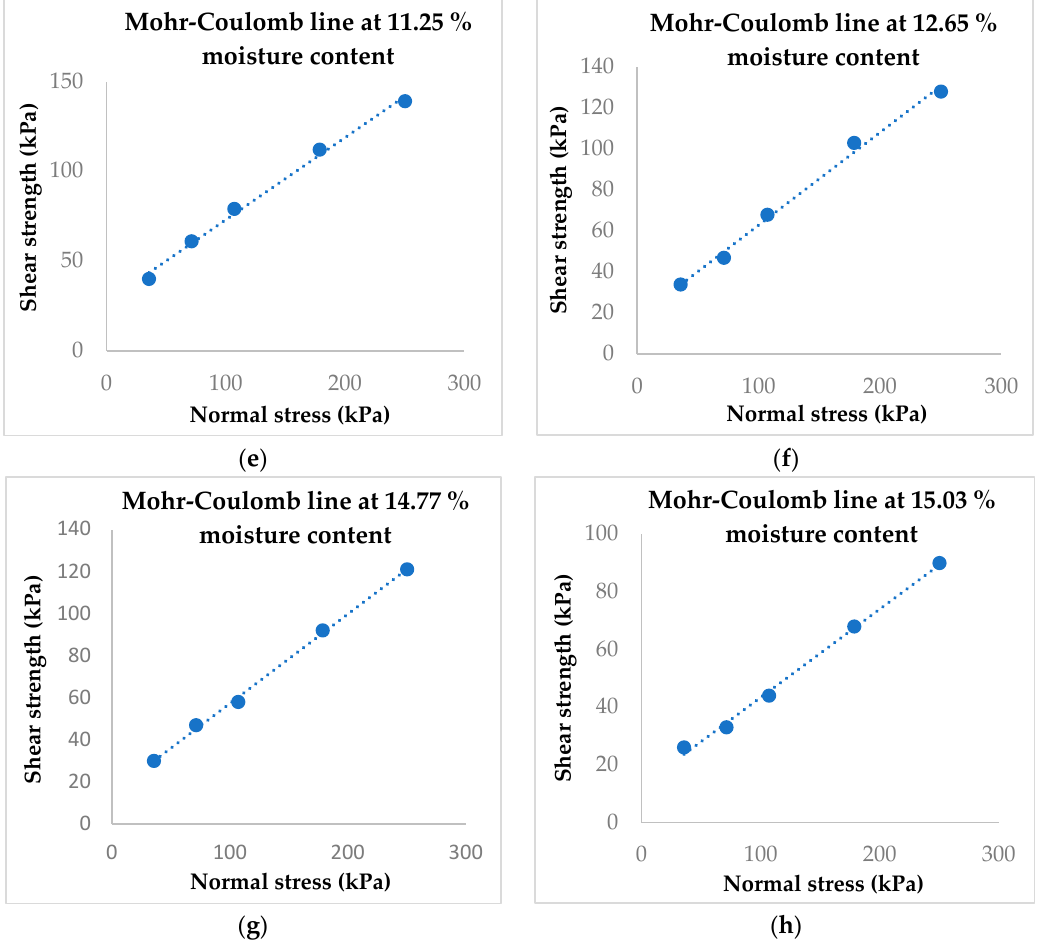
Figure 4. ( a – h ) Sandy loam soil Mohr–Coulomb diagrams at different moisture contents.